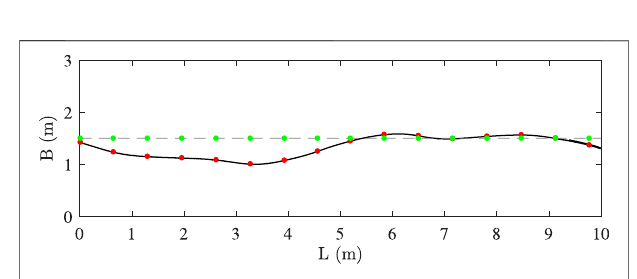
FIGURE 9 | Example of pedestrian trajectory (black line), foot positions on the trajectory (red dots) and projection of the foot positions on the bridge centerline (green